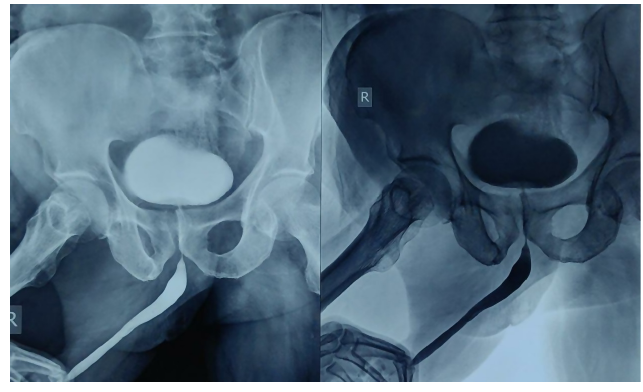
Figure 2. Preoperative retrograde urethrogram showing penile urethral stricture.